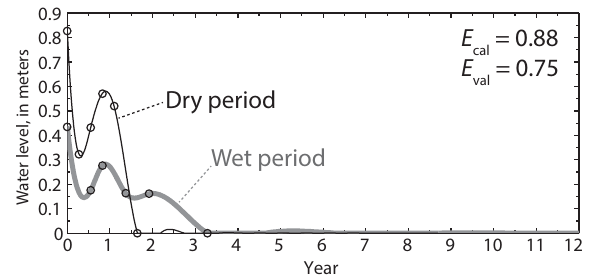
Figure 10. Example W3: nonparametric impulse-response func- tions for well LA88C using a total of 10 control